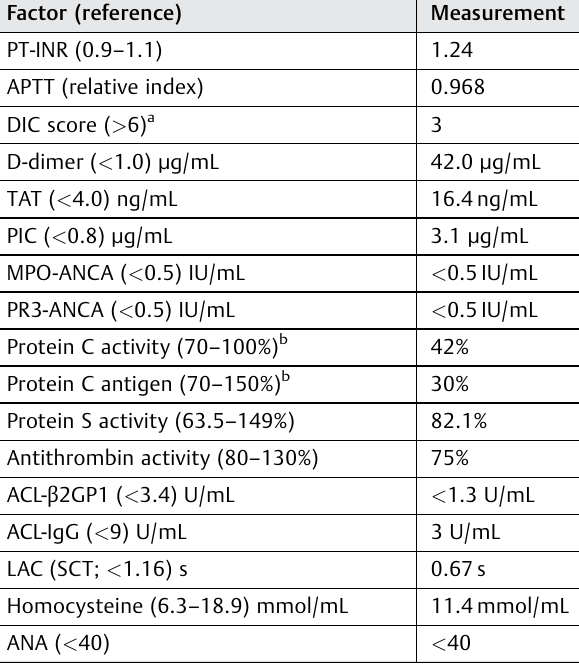
Table 1 Summary of coagulation/ fi brinolysis and autoimmune